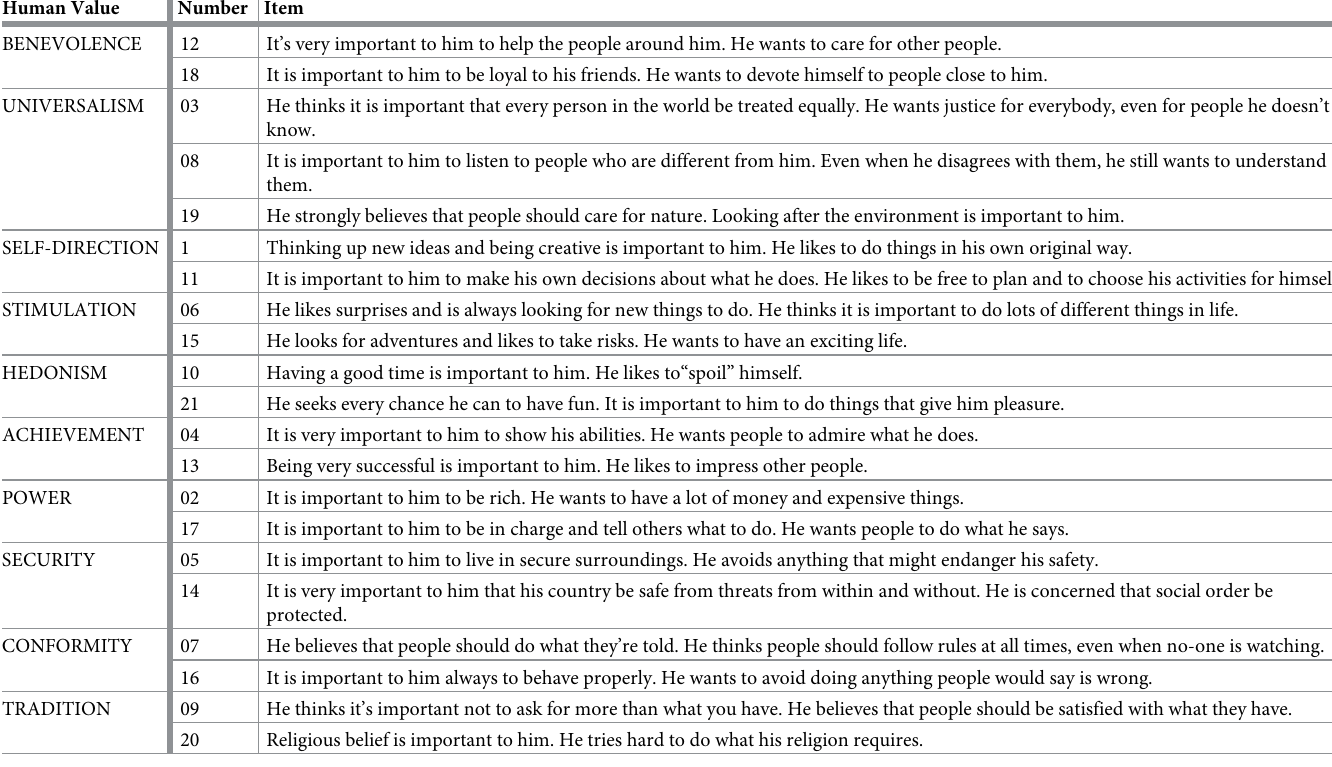
Table 1. Items in SVS questionnaire and their associated human